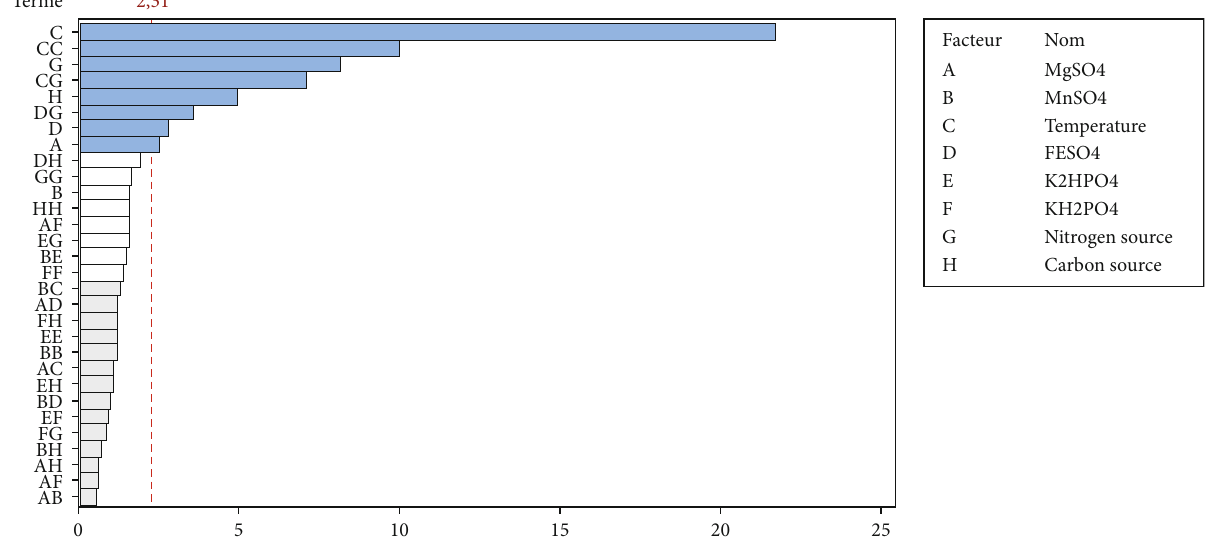
Figure 2: Pareto chart of the e ff ects of variables on LA production in fermentation broth. The grey bars represent terms not included in the model. Table 6: Analysis of variance ( p values, contribution of factors (CF), and coe ffi cient of factors (Coe ff